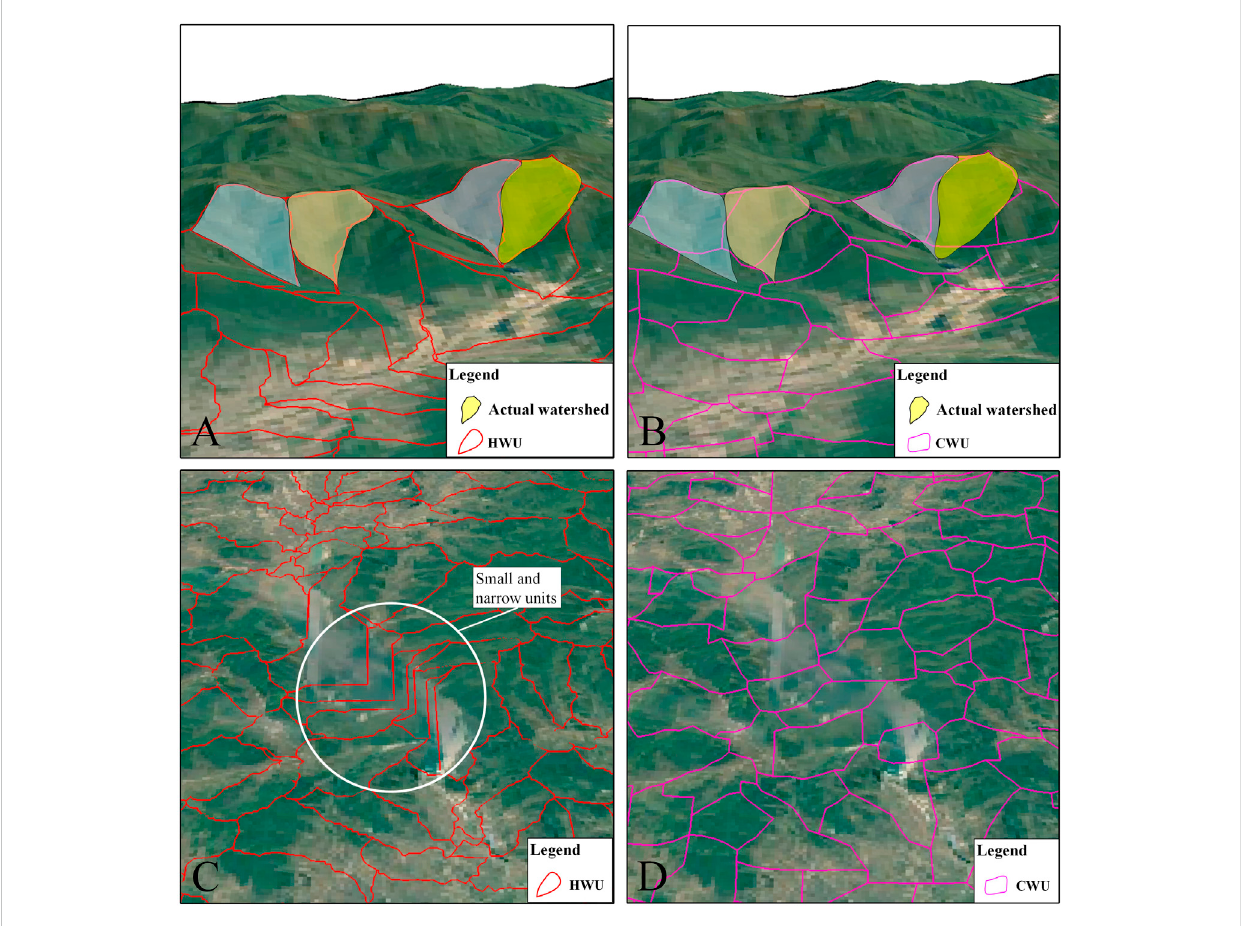
FIGURE 11 Watershed unit classi fi cation results comparison: (A) The boundaries of HWUs are relatively consistent with reality in mountainous areas; (B) The boundaries of CWUs do not match well with the actual situation in mountainous areas; (C) Small and narrow units in fl at areas of HWUs; and (D) The division of CWUs in fl at areas is relatively satisfactory.